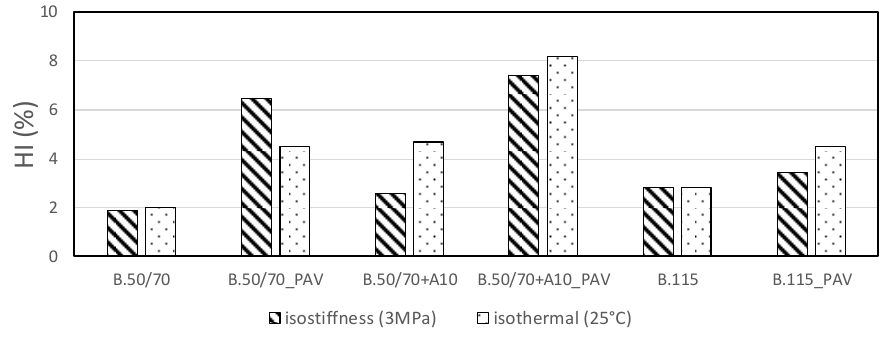
Figure 9. Healing index (HI) results at each testing conditions.